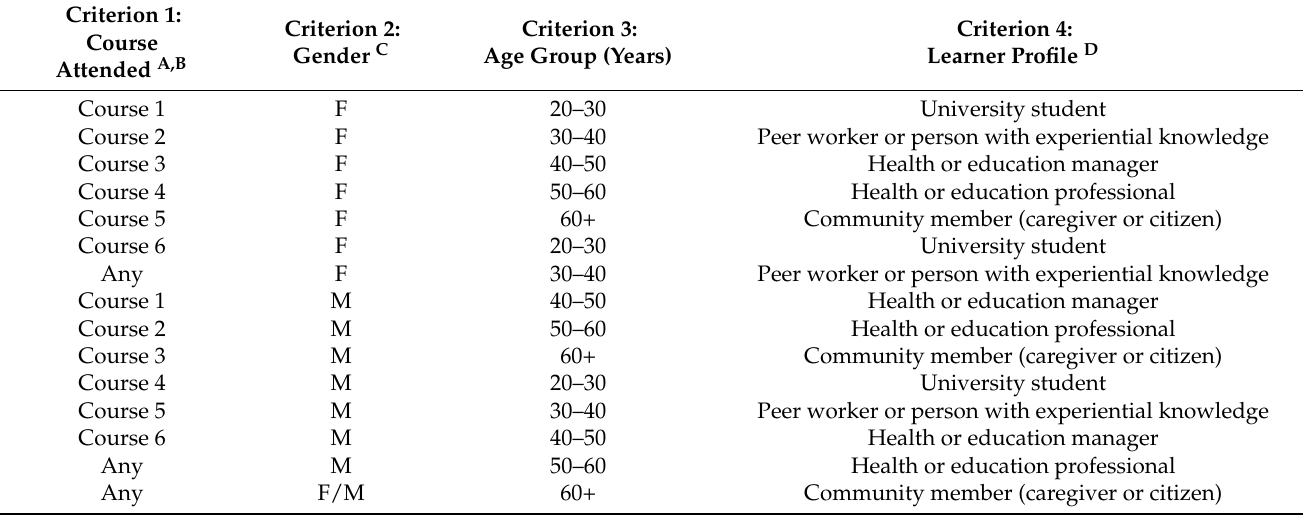
Table 1. Purposive sampling